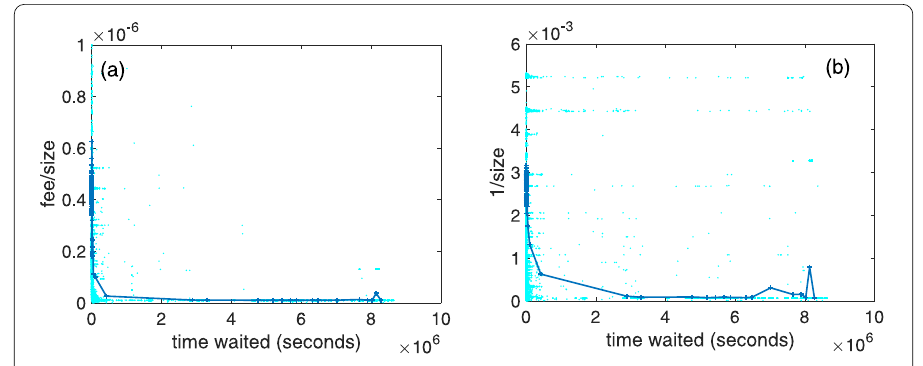
Figure 8 Fee/size and 1/size vs time. ( a ) Fee/size vs time. Fee-per-byte paid for a transaction vs. time waited before the transaction is registered in the blockchain. ( b ) 1/size vs time. Inverse of the size of a transaction vs. time waited before the transaction is registered in the blockchain